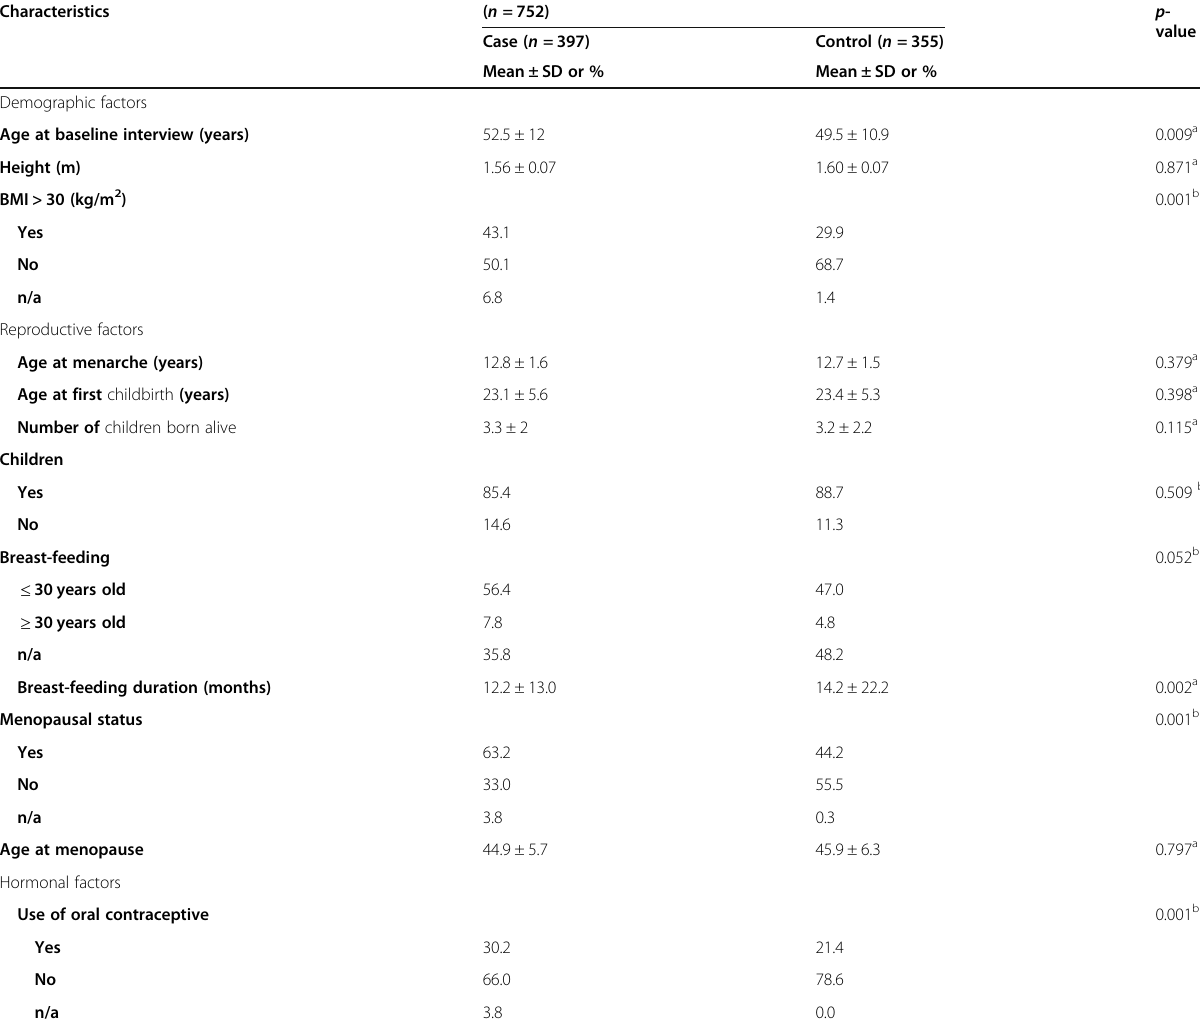
Table 1 Comparison of 12 characteristics in case and control groups Characteristics